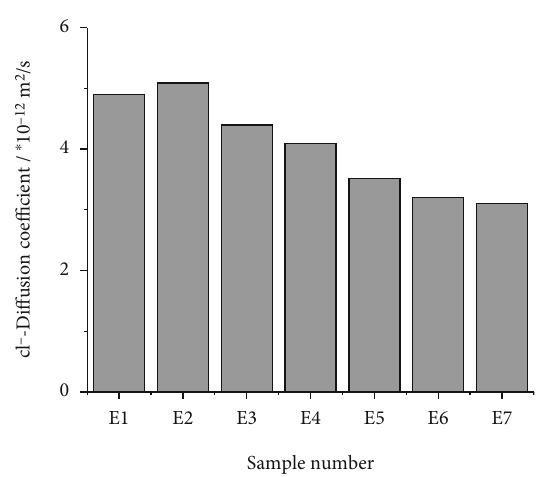
Figure 2: Chloride di ff usion coe ffi cient of pile foundation concrete in 28